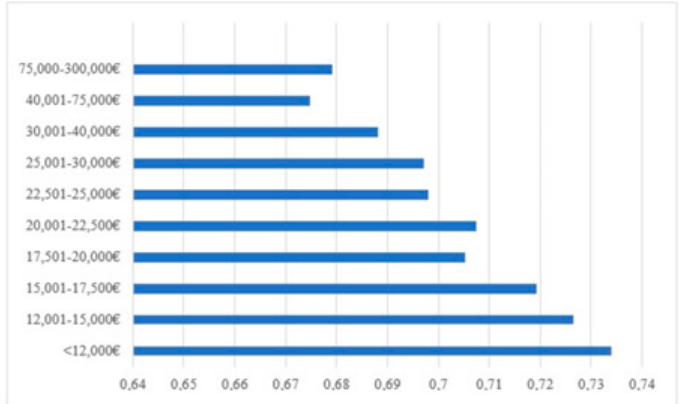
Figure 1. Distribution of annual salary and likelihood of fear of infection in the regions of Madrid, Cantabria and the Canary Islands.